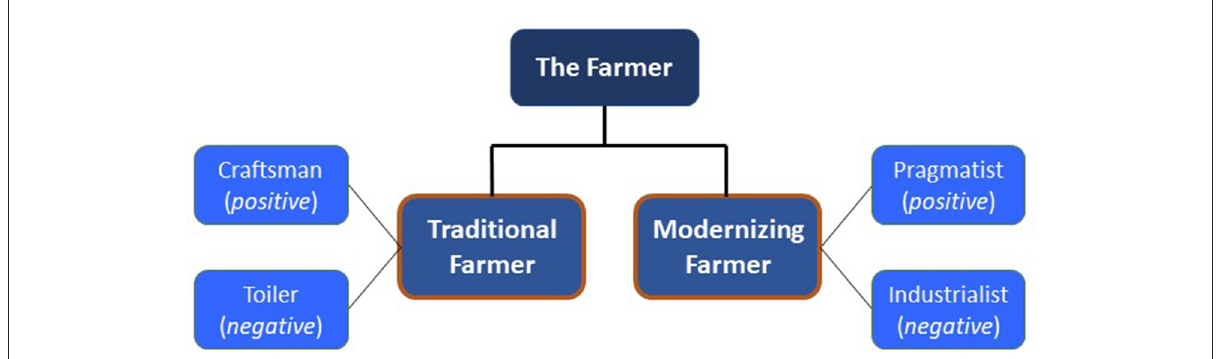
FIGURE2 Summary of the different frames for the farmer and the underlying positive and negative “narratives” through which each frame was expressed.